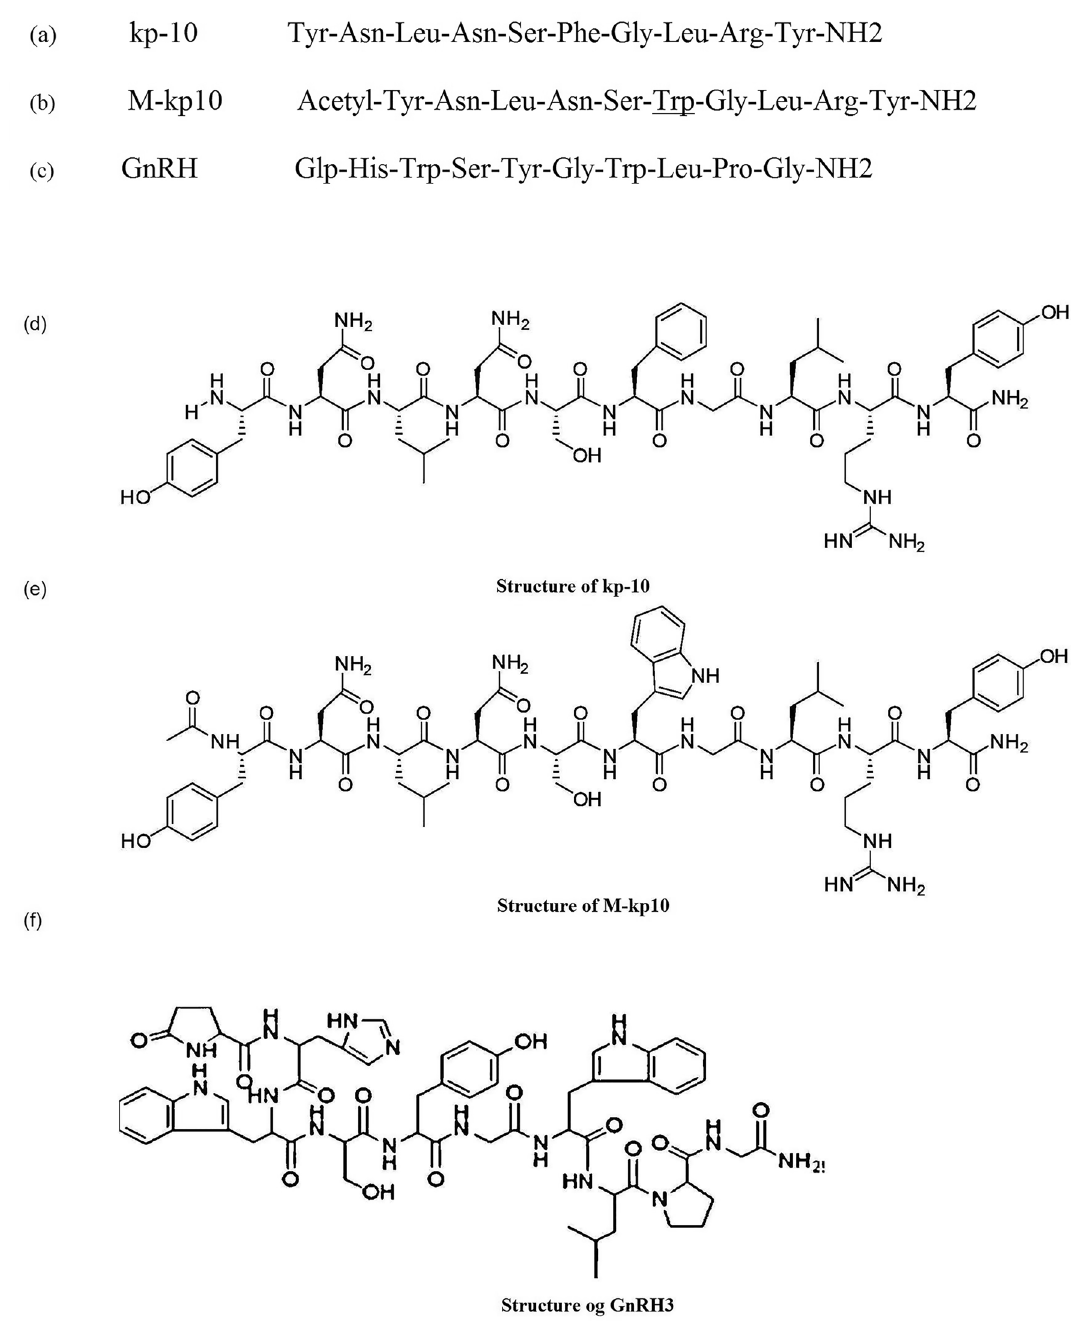
Figure 8. Sequence and structure of peptides. Sequences of ( a ) native kp-10, ( b ) M-kp10 in which Phe 6 is substituted with Trp and the N-terminus is acetylated, and ( c ) GnRH3, and structure of ( d ) kp-10, ( e ) M-kp10, and ( f )